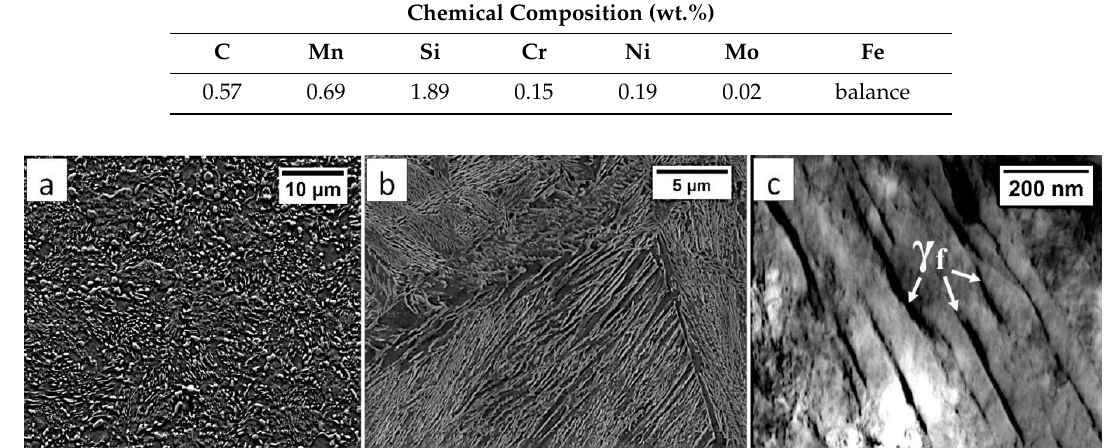
Figure 1. The structure of 55Si7 steel ( a ) in the as-delivered state, and ( b , c ) after heat treatment for the regeneration technique. ( a ) Spheroidal cementite with ferrite matrix. Locally visible cementite with lamellar morphology, SEM. ( b ) Degenerated upper bainite with lath morphology, SEM. ( c )